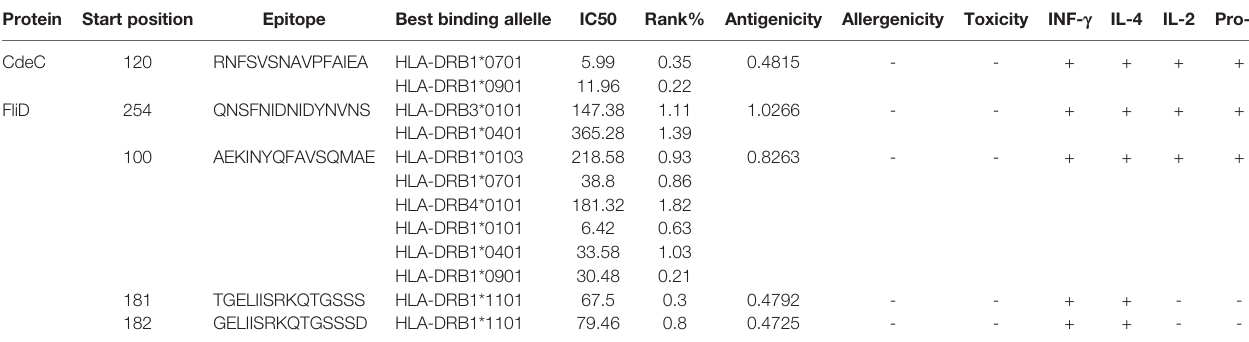
TABLE 2 | Final selected Helper T lymphocyte (HTL) epitopes for vaccine construction. Protein Start position